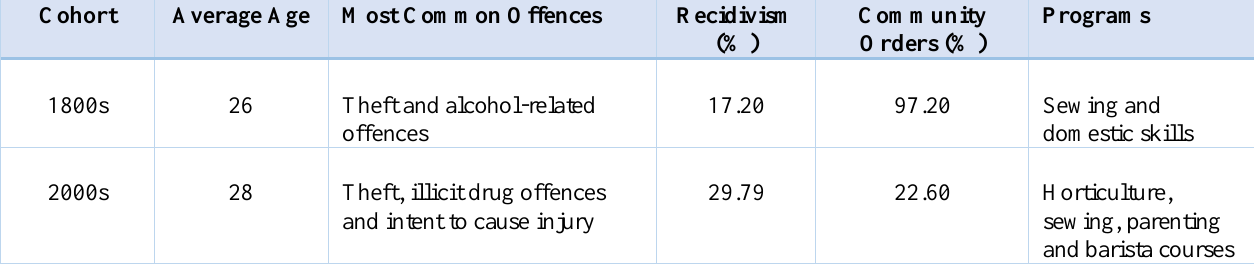
Table 1: Characteristics of women prisoners during the 1800s and 2000s